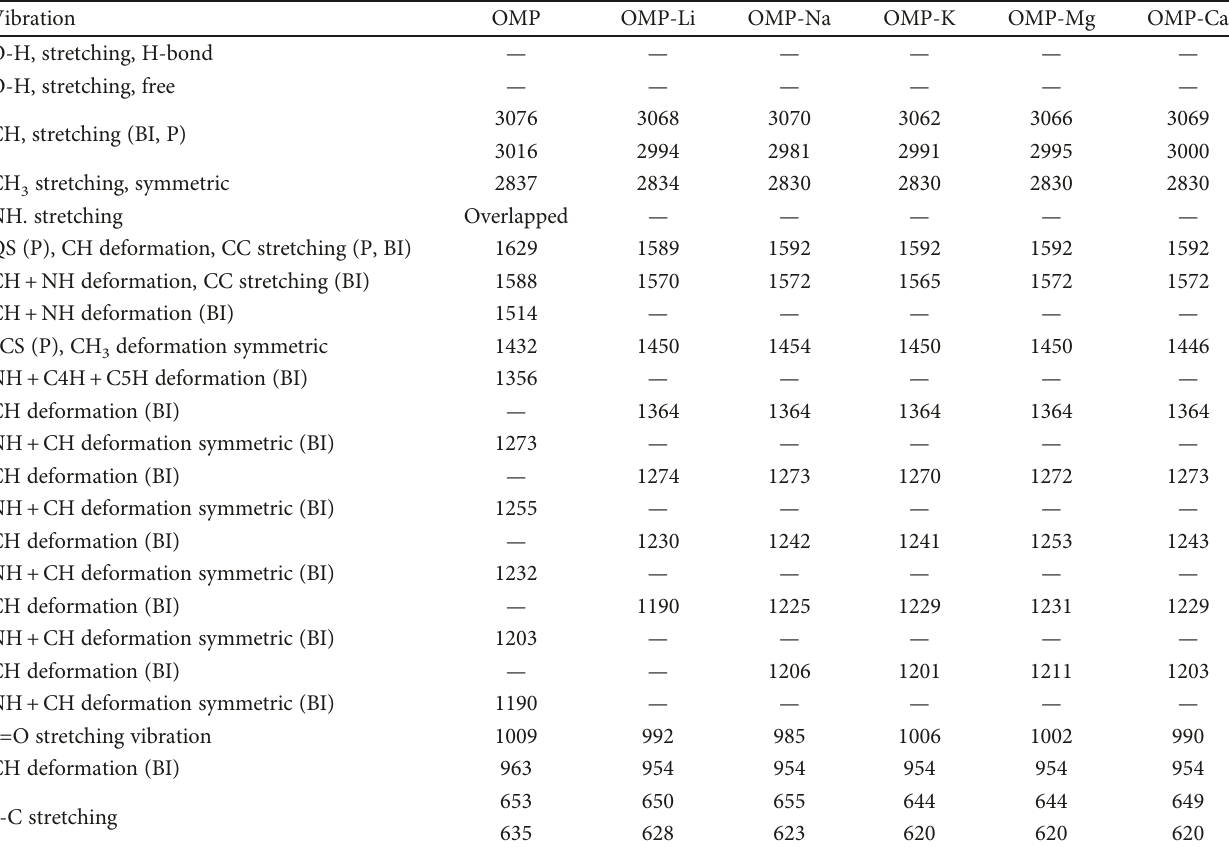
Table 5: Description and comparison of speci fi c vibrations in Raman spectra of OMP and its salts. Vibration OMP O-H, stretching, H-bond — — — — — O-H, stretching, free — — CH, stretching (BI, P) CH stretching, symmetric 3 NH. stretching Overlapped — — QS (P), CH deformation, CC stretching (P, BI) CH+ NH deformation, CC stretching (BI) CH+ NH deformation (BI) SCS (P), CH deformation 3